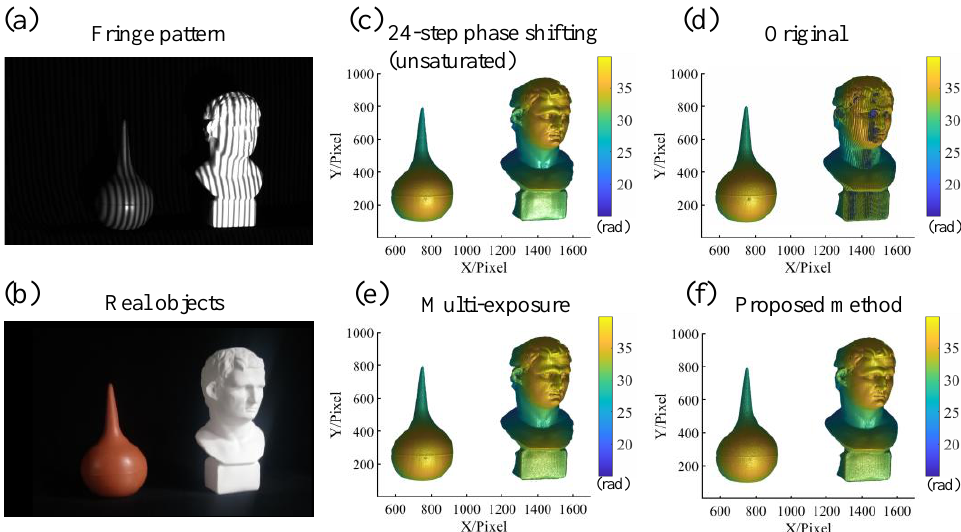
Figure 9. Comparison of experimental results of different methods. ( a ) Saturated fringes. ( b ) Real objects. ( c ) Ground truth was obtained by the 24-step phase-shifting method under unsaturated conditions. ( d ) Phase calculated directly from saturated fringes. ( e ) Phase recovered by the multiexposure method. ( f ) Phase recovered by the proposed method.